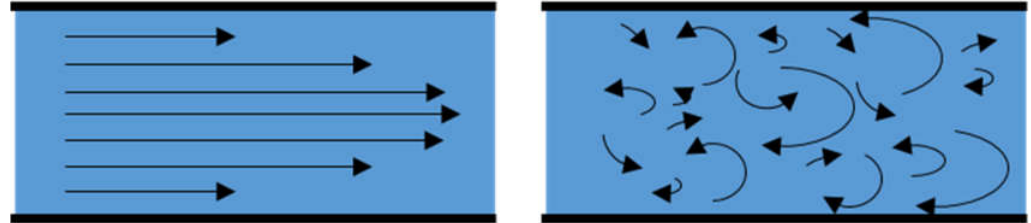
Figure 1. Schematic representation of flow lines in microscale and macroscale. Flow lines follow straight paths in microscale with a parabolic profile; contrary to macroscale, flow lines follow crossing paths with no defined pattern.